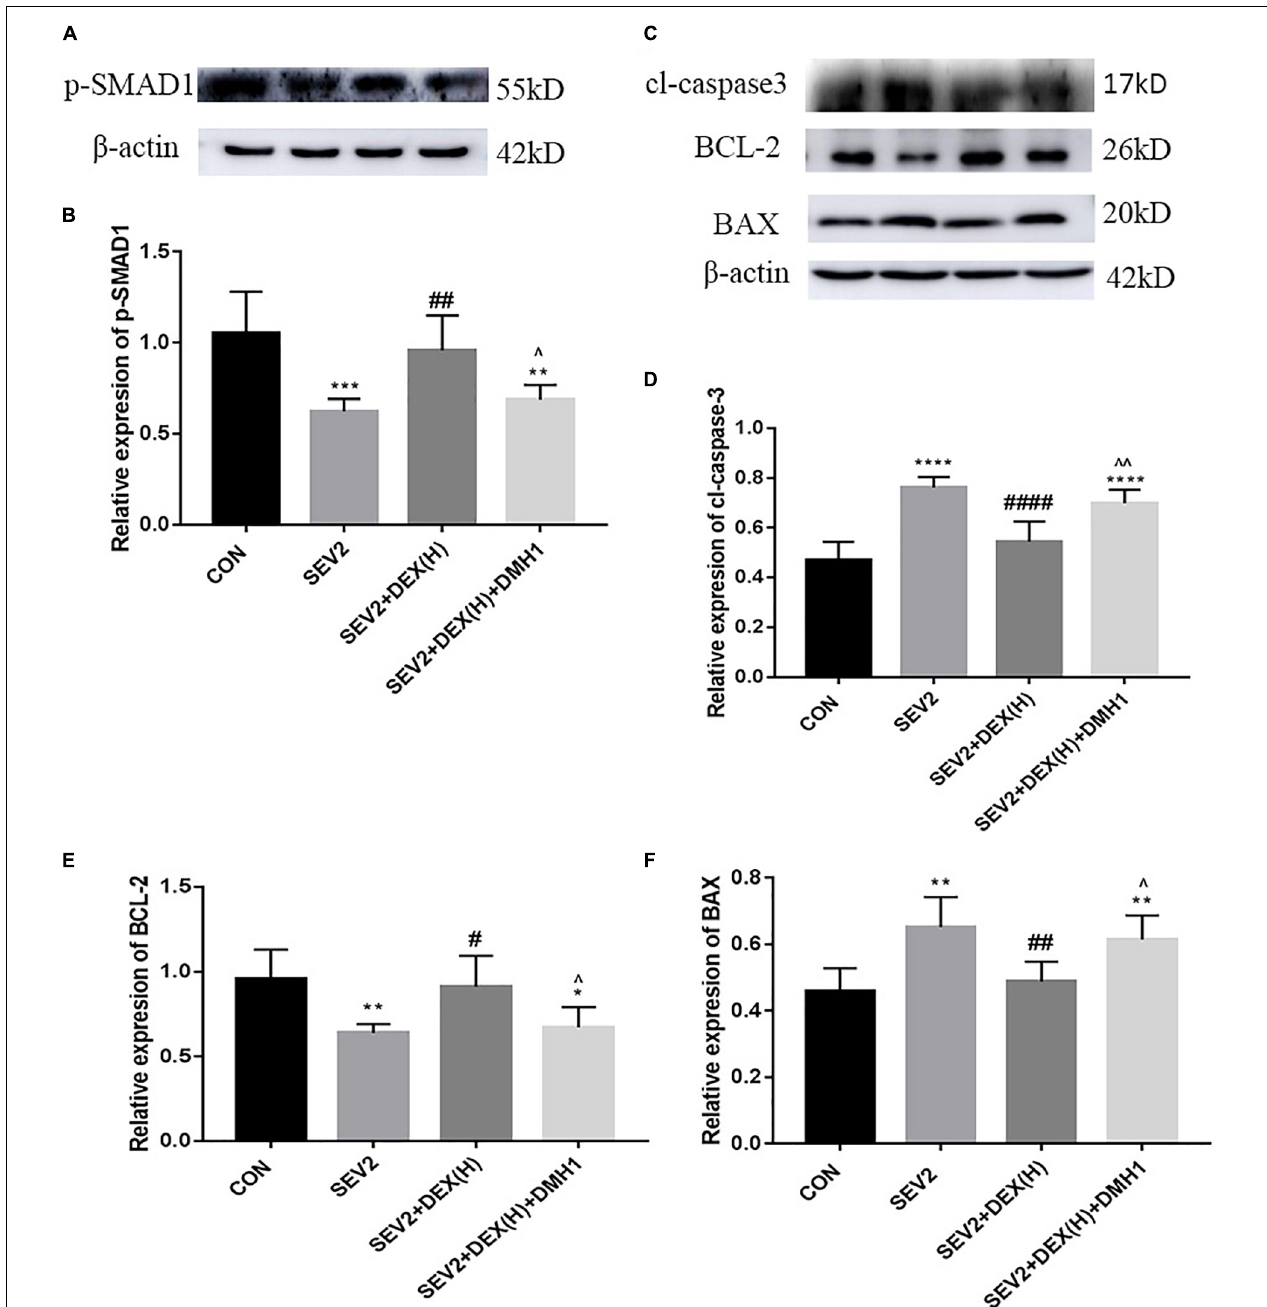
FIGURE 6 | DMH1 suppressed the anti-apoptosis effect of Dex against sevoflurane anesthesia. Representative Western blot for the expression levels of p-SMAD1 (A) , cl-caspase3, BCL-2, and BAX (C) at P1. Quantification of p-SMAD1 (B) , cl-caspase3 (D) , BCL-2 (E) , and BAX (F) normalized to β -actin. Data are expressed as the means ± SEM ( n = 6 in each group). Result comparisons were made using one-way ANOVA and post hoc Tukey’s correction. ∗∗ P < 0.01, ∗∗∗ P < 0.001, ∗∗∗∗ P < 0.0001, compared to the CON group; # P < 0.05, ## P < 0.01, ### P < 0.001, #### P < 0.0001 compared to the SEV2 group; ∧ P < 0.05, ∧∧ P < 0.01, compared to the SEV2+DEX(H)